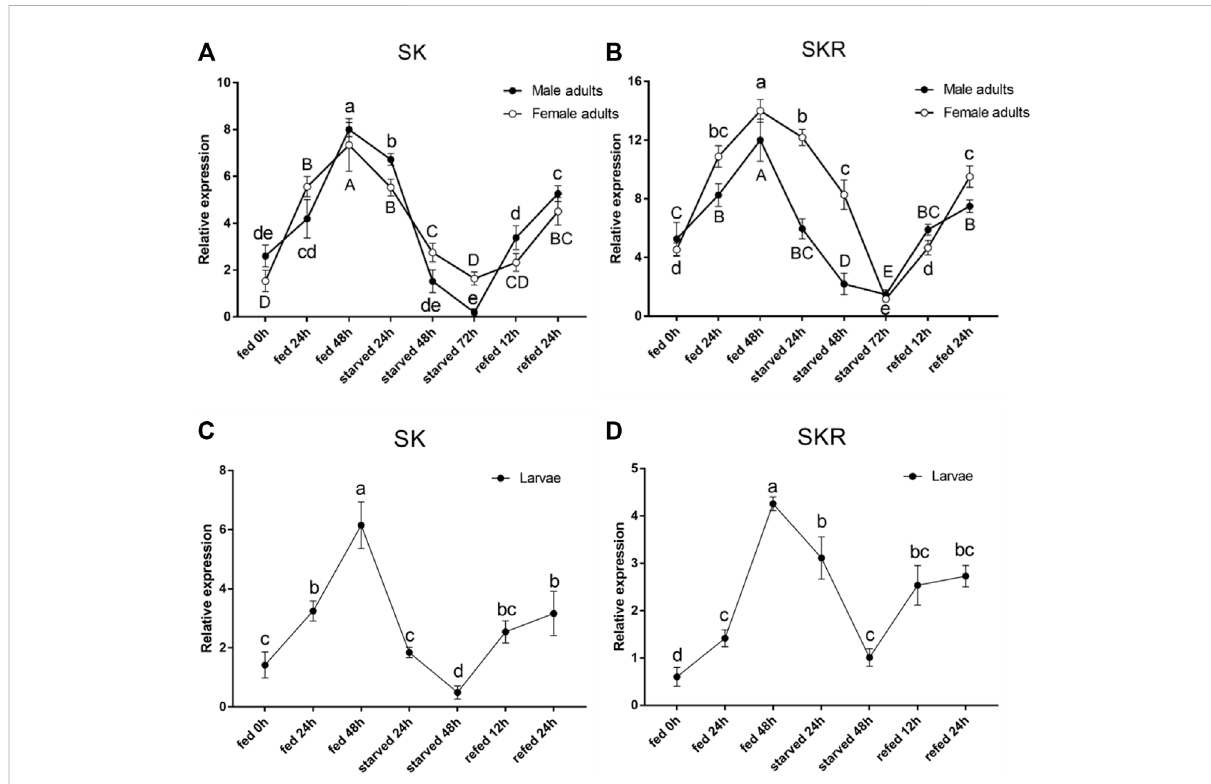
FIGURE 5 Relative expression levels of SK (A) and SKR (B) in emerged adults and SK (C) and SKR (D) in larvae after starvation and subsequent re-feeding treatment in D. armandi . The relative expression levels were normalized with β -actin and CYP4G55 using the expression levels in the 0 h for calibration. Different letters indicate signi fi cant differences at the 0.05 level (uppercase for males, lowercase for females, uppercase for males and larvae, and no letter means no signi fi cant difference among all time points). All values are mean ± SE , n =